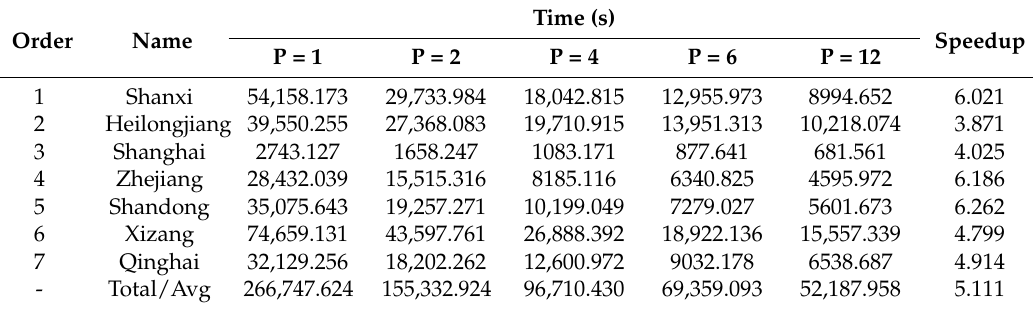
Table 5. Performance improvement in a multicore CPU environment (P is the number of processes).